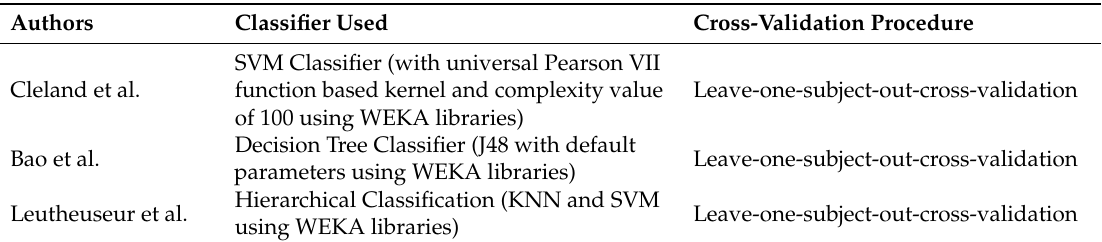
Table B1. Classification procedure used for each PAC